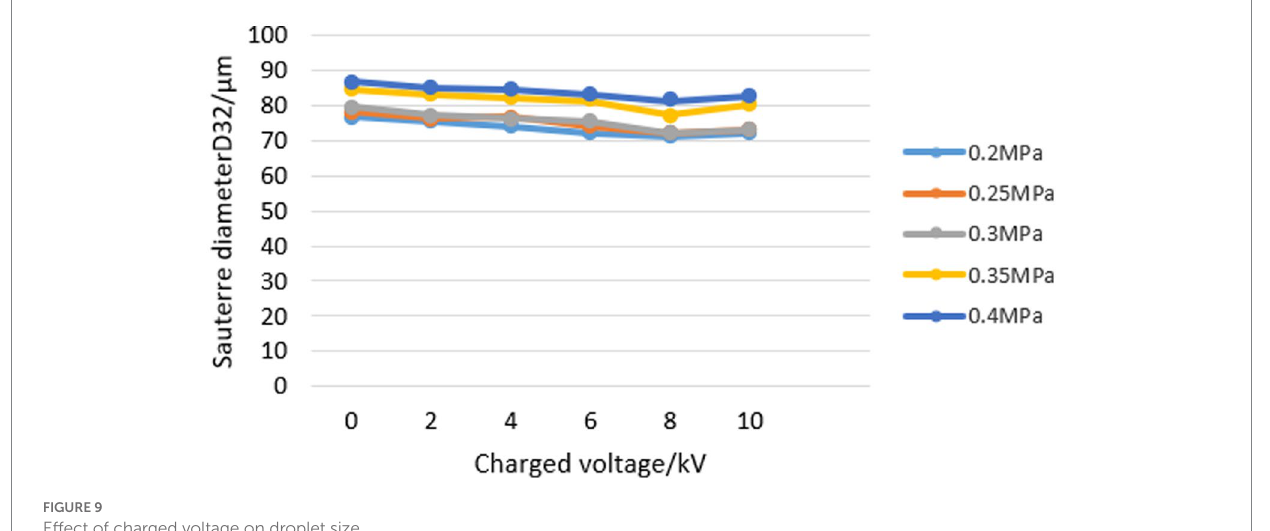
FIGURE 9 Effect of charged voltage on droplet size.